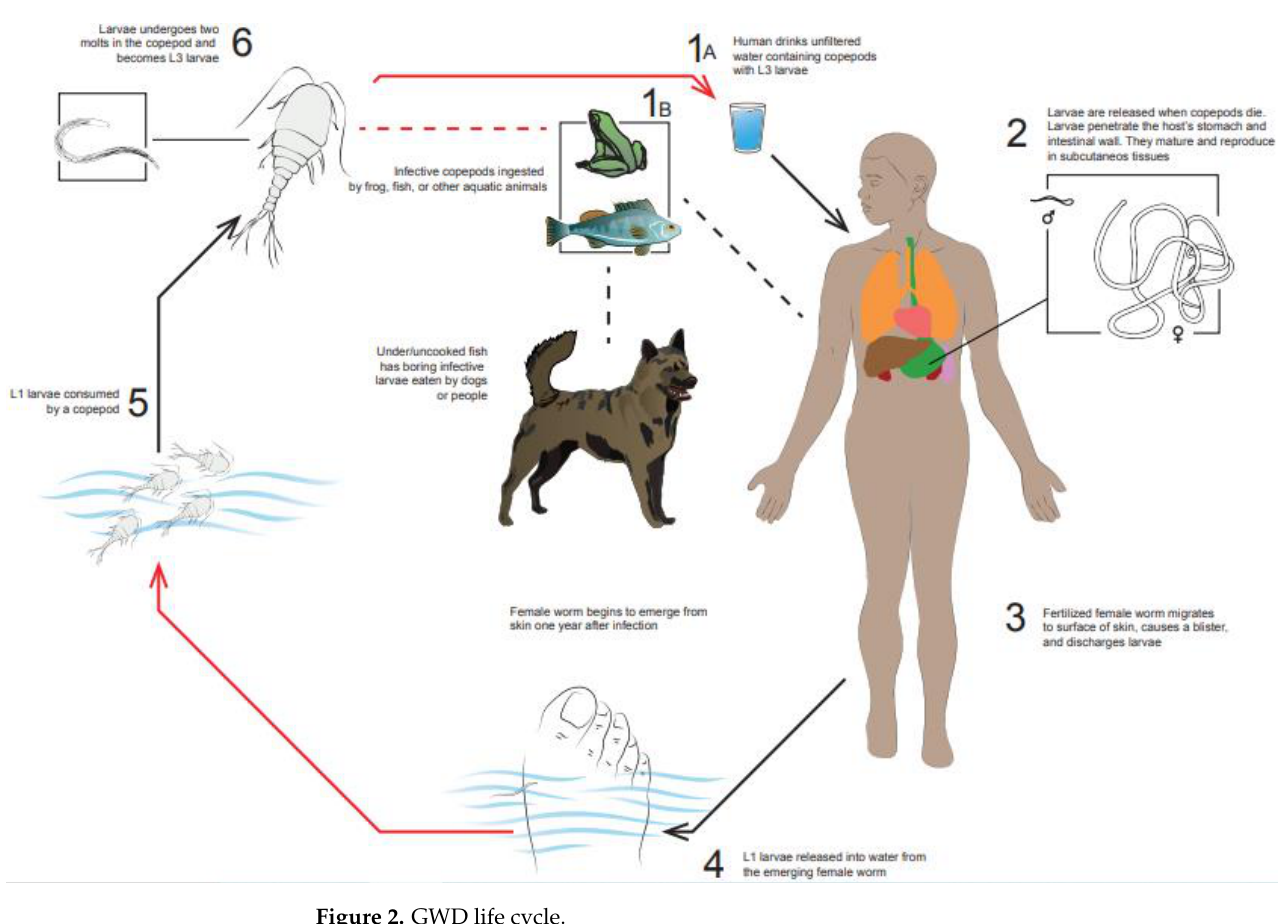
Figure 2. GWD life